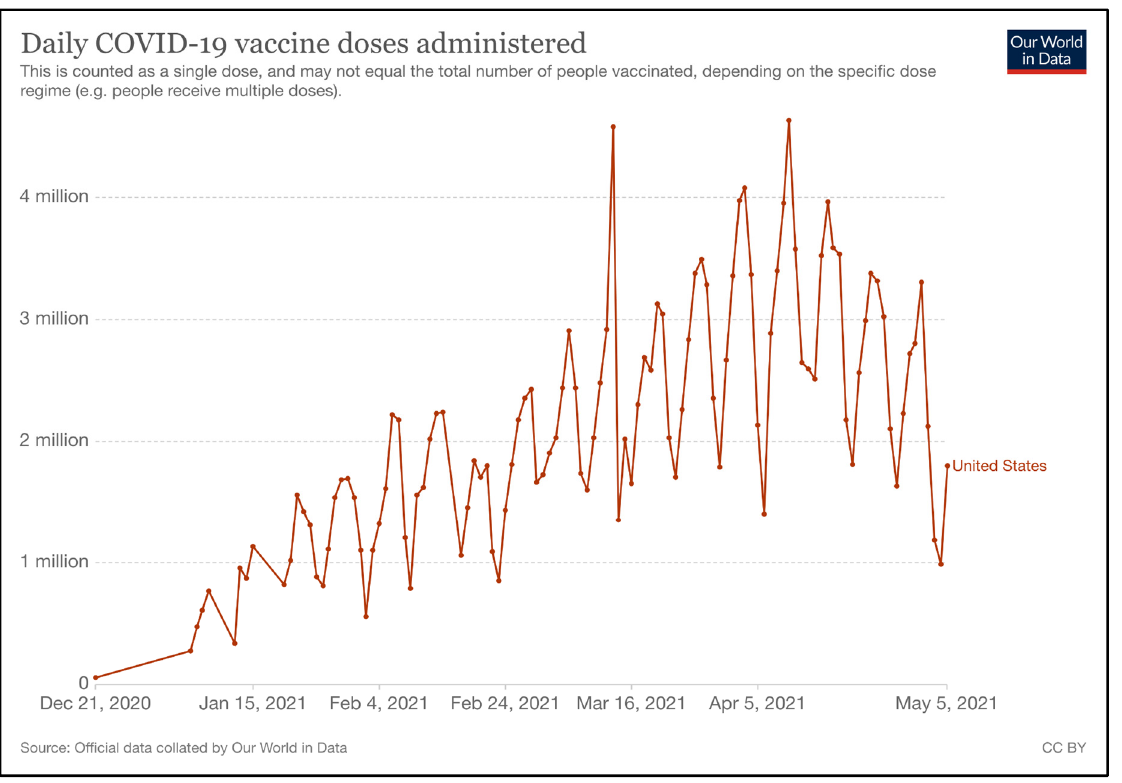
Figure 10. Daily COVID-19 Vaccine Doses Administered (Source: Our World in Data)